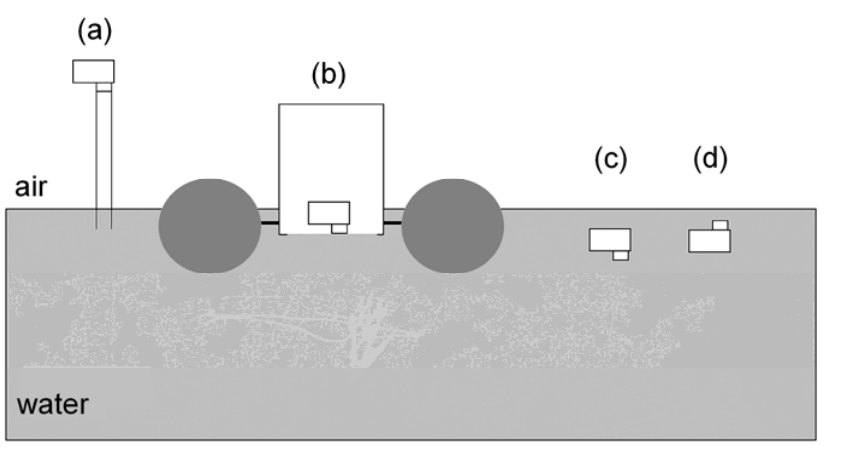
Figure 1. Diagram illustrating camera deployment methods: (a) CP885 with a tube breaking the water surface attached to its lens (b) CP885 in an underwater housing, mounted in a frame kept afloat by four buoys (two shown in diagram) (c) ECOshot underwater camera imaging subsurface up welling light (d) ECOshot underwater camera imaging subsurface down welling